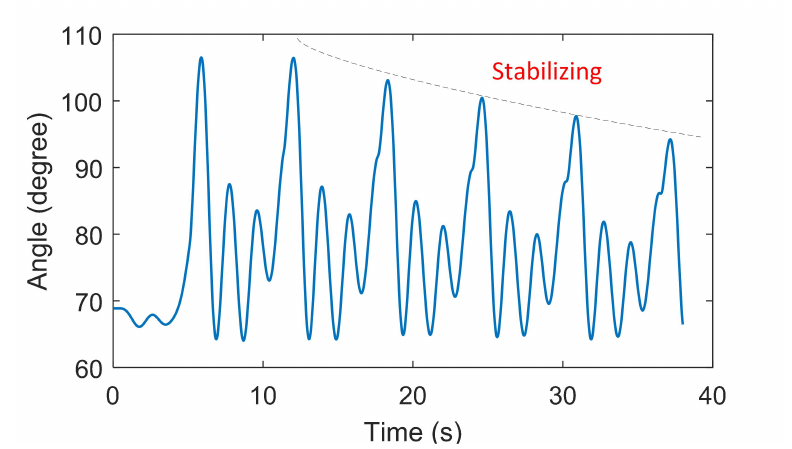
Figure 12. Machine 5–10 angle differences under a moderate FDIA.